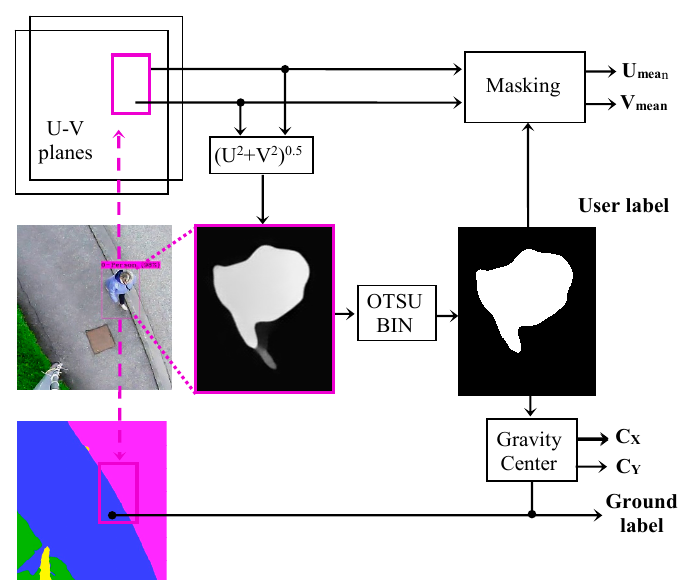
Figure 11. Block diagram of the fusion system.